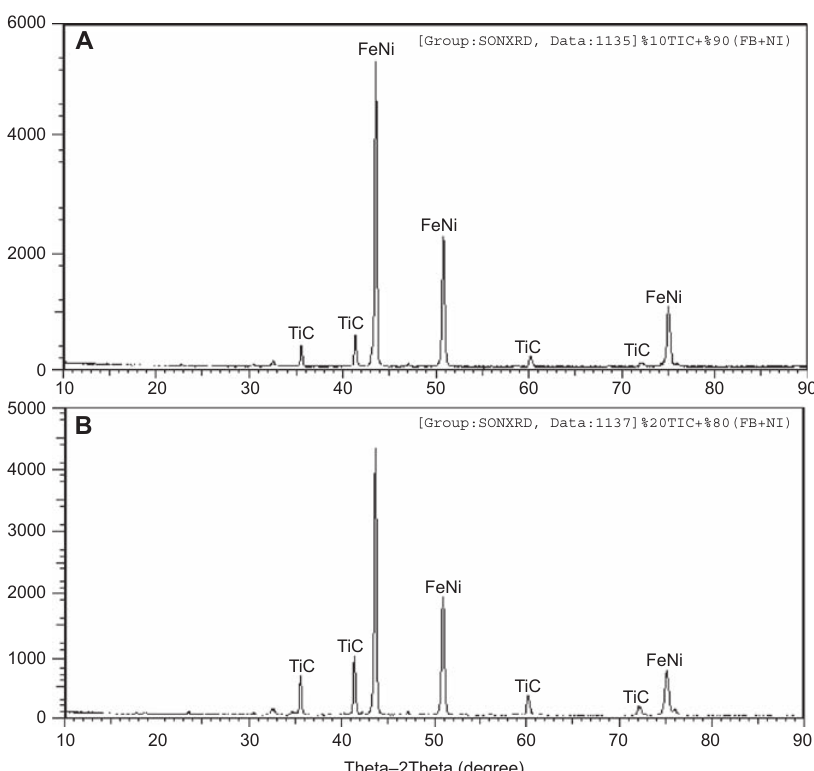
Figure 8 XRD analysis of TiCFeNi composite sintered at 1200 ° C.